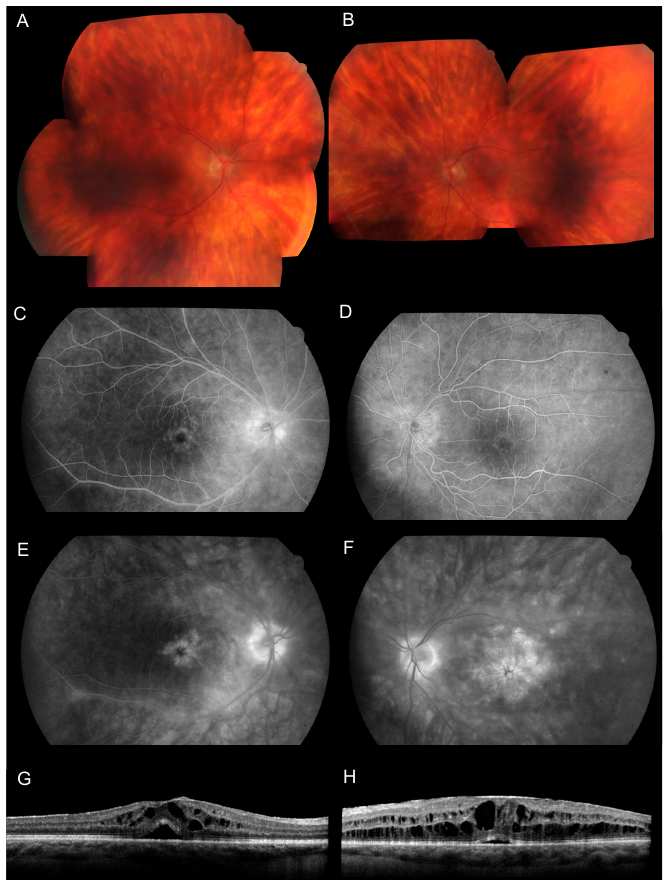
Figure 3. Multimodal imaging of a 46-year-old woman with recently diagnosed BCR. ( A , B ) Color fundus photography shows oval to linear creamy birdshot lesions. ( C – F ) Early-phase ( C , D ) and late-phase ( E , F ) fluorescein angiography shows cystoid macular edema associated with hyperfluorescence of the optic disc in both eyes. ( G , H ) OCT B-scan shows cystoid macular edema with subretinal fluid in both